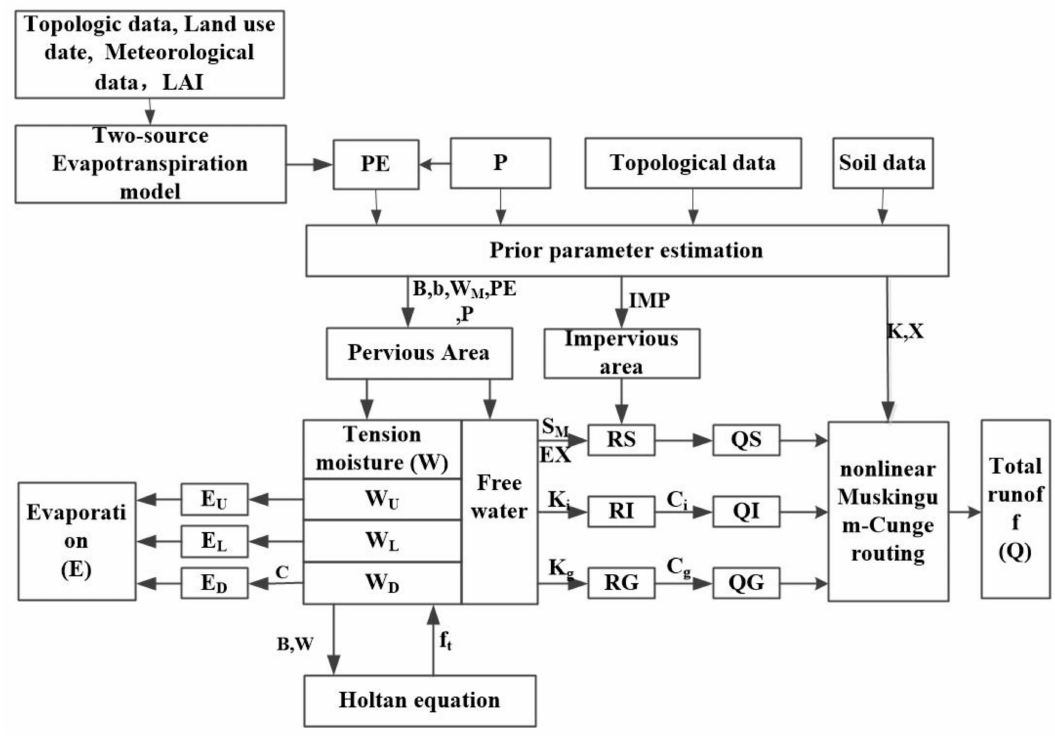
Figure 2. A schematic chart of the modified Grid-Xinanjiang model (GXAJ) model.